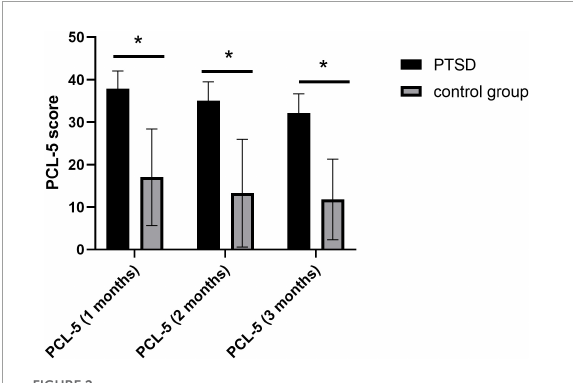
t -value Control group ( N = 17) ( N = 23)